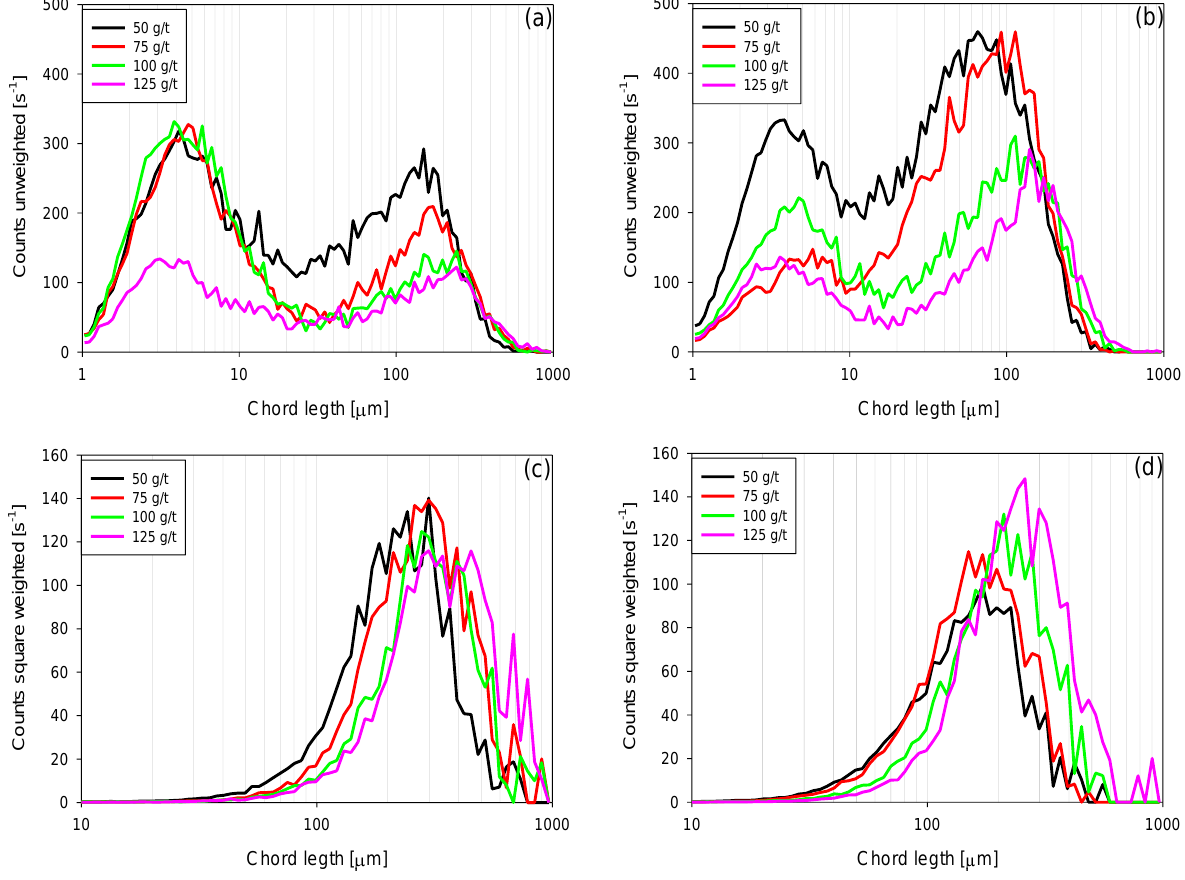
Figure 8. Unweighted ( a , b ) and square-weighted ( c , d ) chord length distribution from flocculated kaolin suspensions in IW ( a , c ) and SW ( b , d ) for different flocculant doses at 180 rpm. Solid concentra- tion 5 wt%, reaction time 15 s, and pH 7.